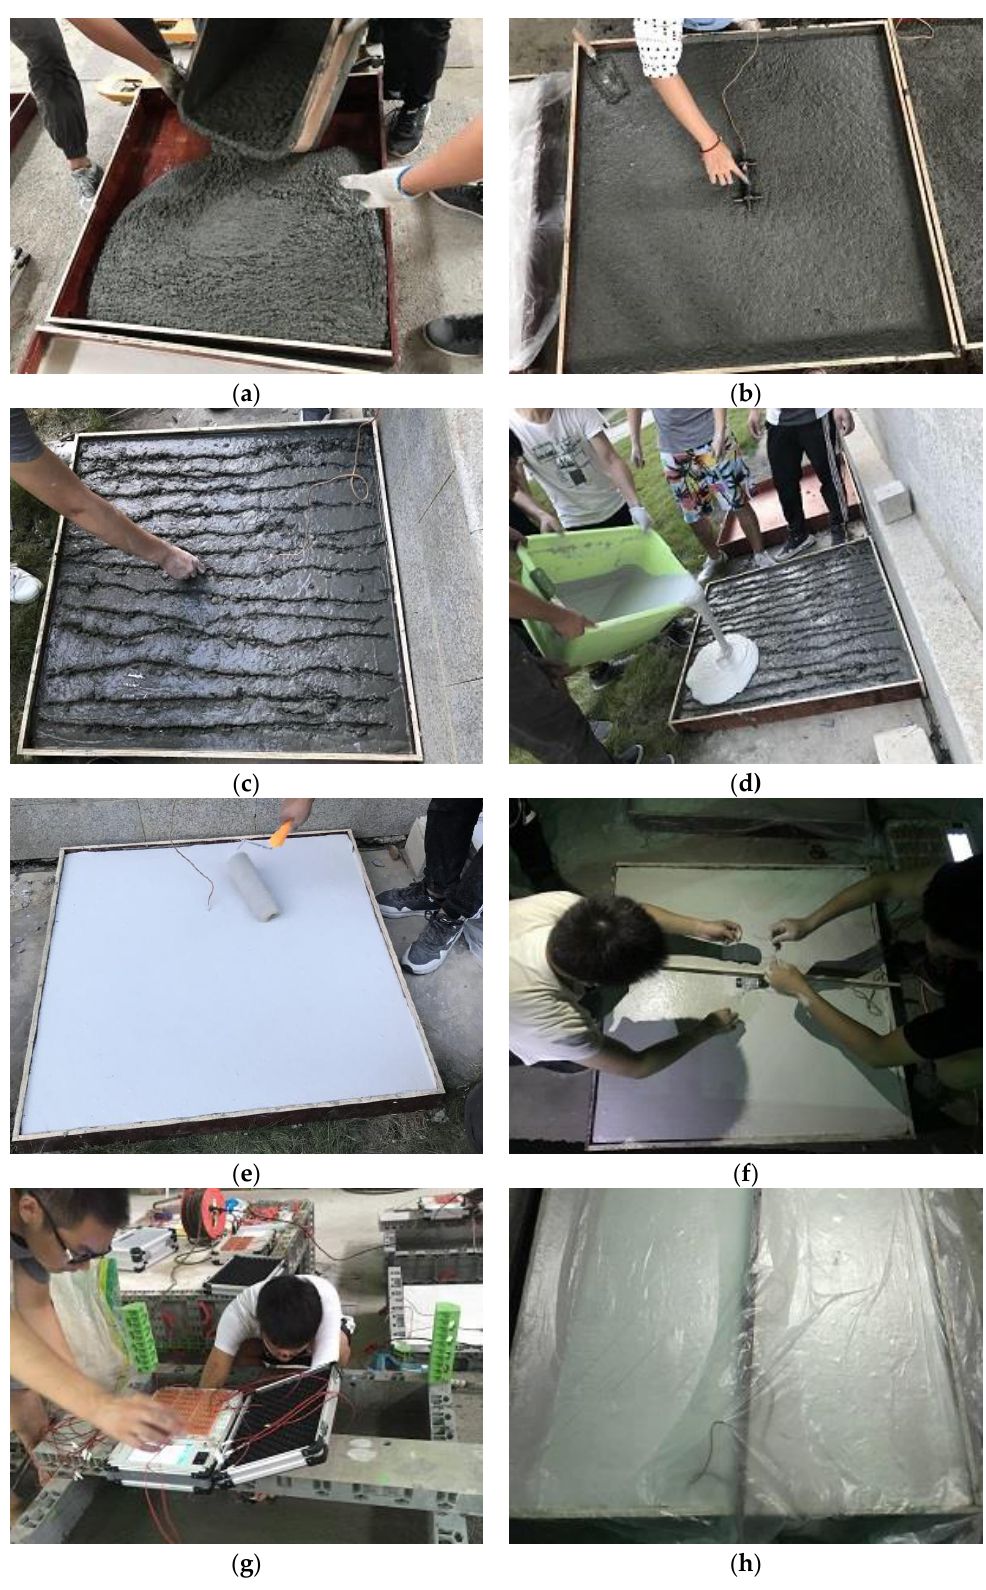
Figure 6. Experimental process: ( a ) pouring concrete; ( b ) placing embedded strain sensor; ( c ) surface processing; ( d ) pouring GRC material; ( e ) leveling the GRC surface; ( f ) placing surface strain sensors; ( g ) connecting the static strain tester; ( h ) covering film maintenance.